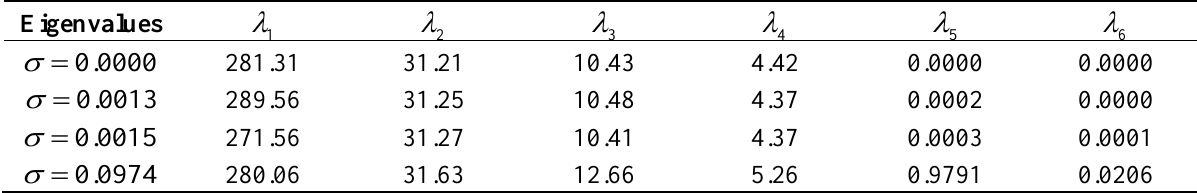
Table 2. Eigenvalues of covariance matrix with different factor 